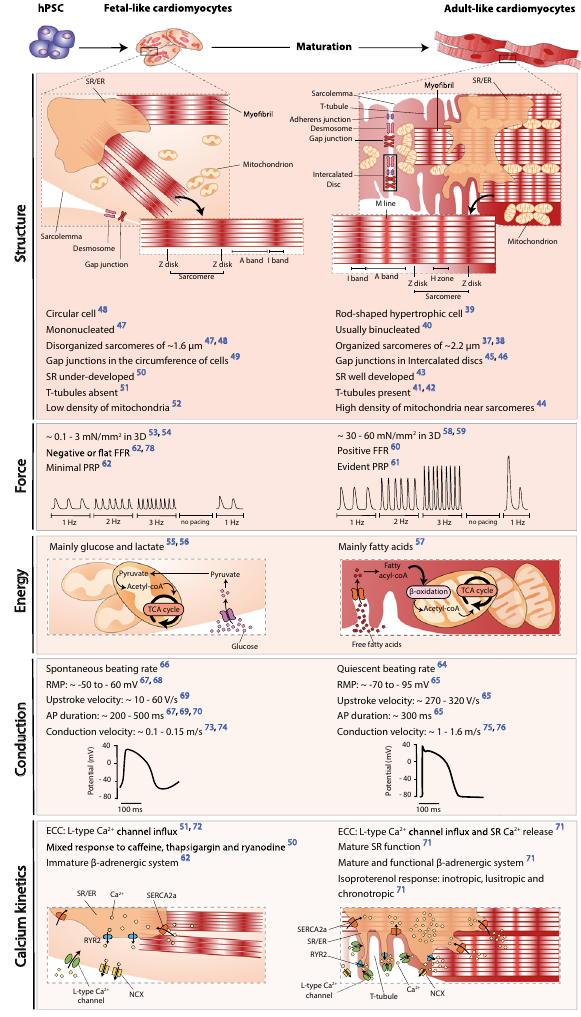
Fig. 1 Differences between human pluripotent stem cell-derived cardiomyocytes (hPSC-CMs) and ventricular cardiomyocytes from adult cardiac tissue. hPSC-CMs obtained from the differentiation of pluripotent stem cells present fetal-like features in respect to structural and ultrastructural organization, contractile force, meta- bolism, and electrophysiological function. AP action potential, ECC excitation – contraction coupling, FFR force – frequency relationship, hPSCs human pluripotent stem cells, NCX sodium – calcium exchan- ger, PRP post-rest potentiation, RMP resting membrane potential, RYR2 ryanodine receptor type 2, SERCA2a sarcoplasmic/endoplas- mic reticulum calcium-ATPase 2a, SR/ER sarcoplasmic/endoplasmic